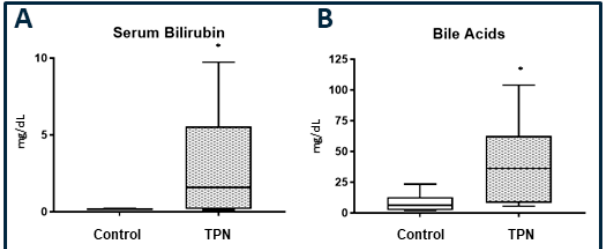
Figure 1. ( A ): Serum bilirubin. (B) Total serum bile acids. Significantly high serum bilirubin and bile acids levels were found with total parenteral nutrition (TPN) compared to enteral nutrition (control).